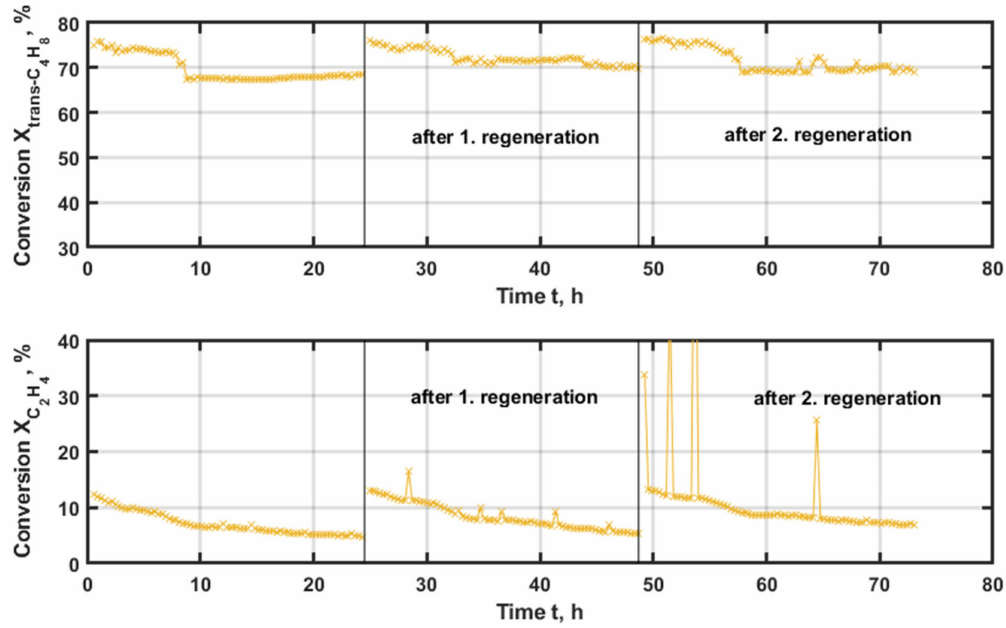
Figure 6. Conversion of the applied reactants trans-butene (upper graph) and ethene (lower graph) with time-on-stream (TOS) applying Re/AlMCM-41(60) as the catalyst at 200 ◦ C and 500 kg cat · s · m − 3 , with regeneration at 500 ◦ C and 20% oxygen for 3